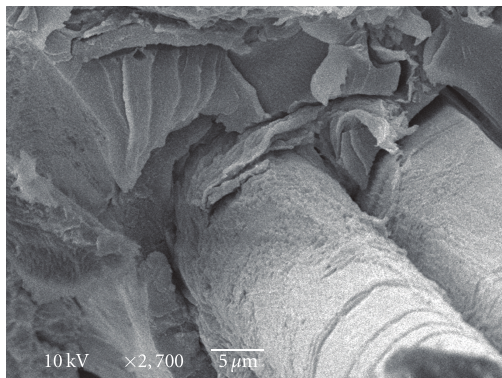
× 2,700 5 µ m10kV Figure 4: A representative SEM image of a failed composite sample with retted (46h)